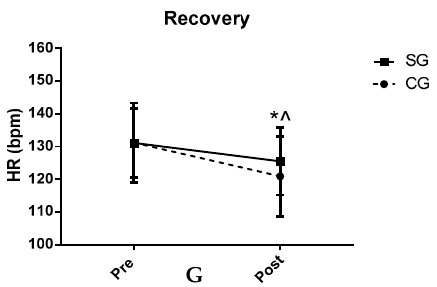
Figure 1. Results of the incremental test: ( A ) ergospirometric values corresponding to VT1; ( B ) ergospirometric values corresponding to VT2; ( C – F ) maximum values of the incremental test; ( G ) results obtained after three minutes of recovery. CG: control group; SG: supplemented group; HR: heart rate; VO 2 : oxygen consumption; * p < 0.05 di ff erences pre vs. post in SG; ** p < 0.01 di ff erences pre vs. post in SG; ˆ p < 0.05 di ff erences post CG vs. post SG.